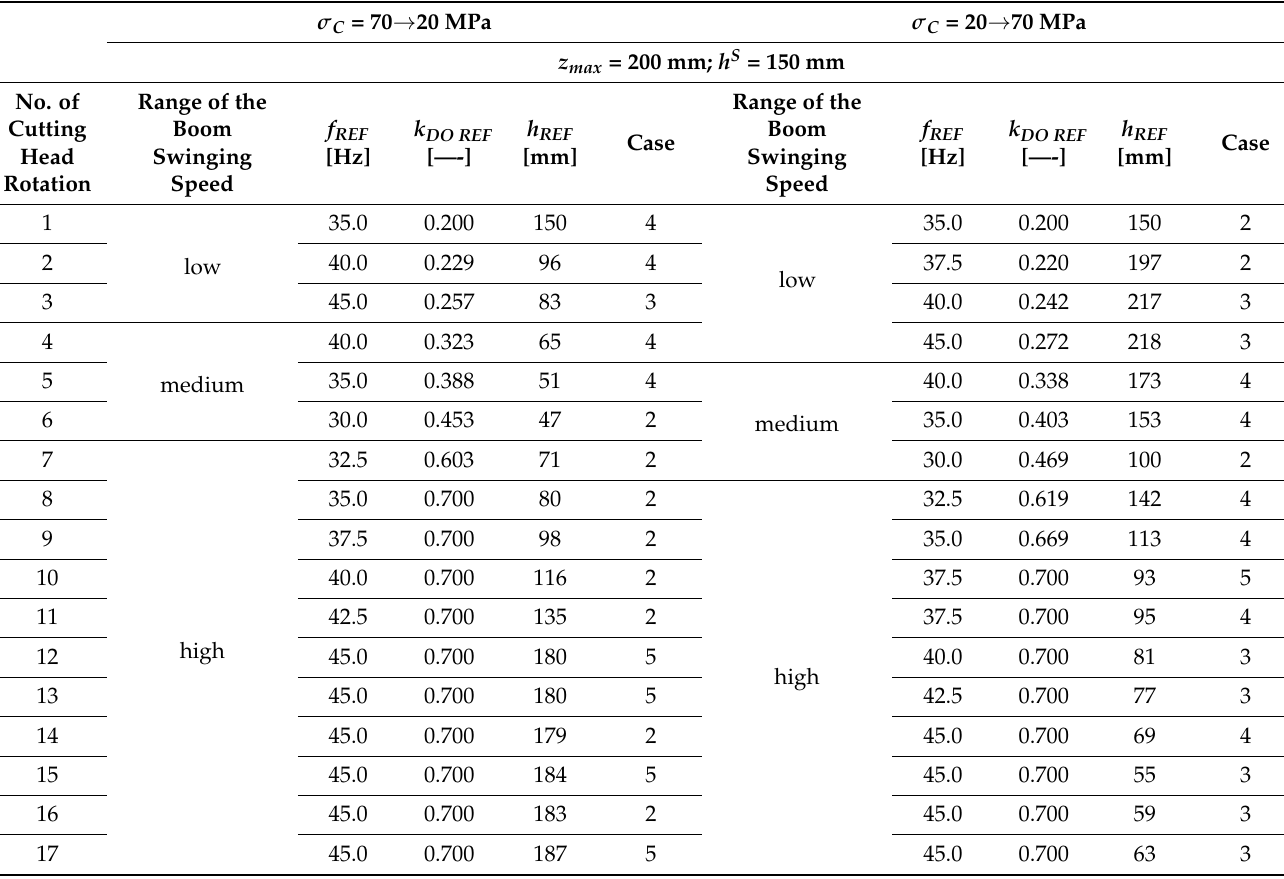
Table 2. Set values of the cutting process parameters determined by the setting system during simulated mining of rocks with variable uniaxial compressive